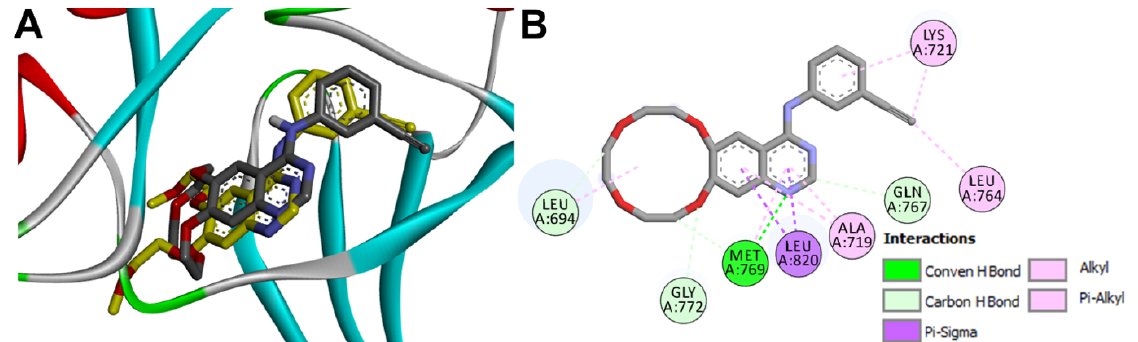
Figure 7. Binding mode/interactions of icotinib (sticks colored by element) into EGFR (pdb: 1M17): ( A ) 3D binding mode of icotinib overlaid with the co-crystallized ligand (yellow sticks); ( B ) 2D binding mode of icotinib showing different types of binding interactions with amino acids in the active site of EGFR.